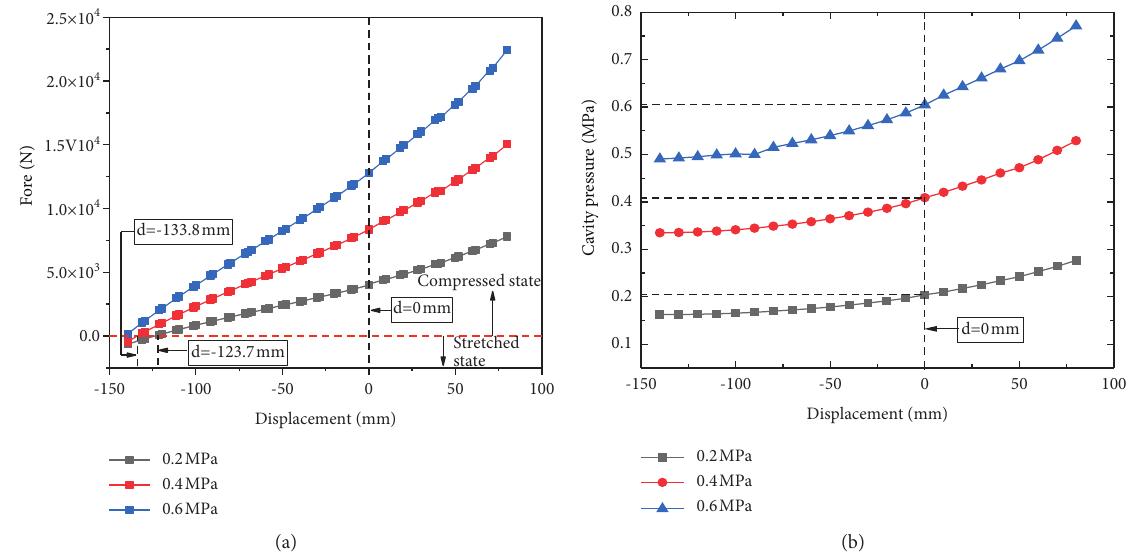
Figure 4: Uniaxial tensile and compression test results of the airbag: (a) for load change and (b) for cavity pressure